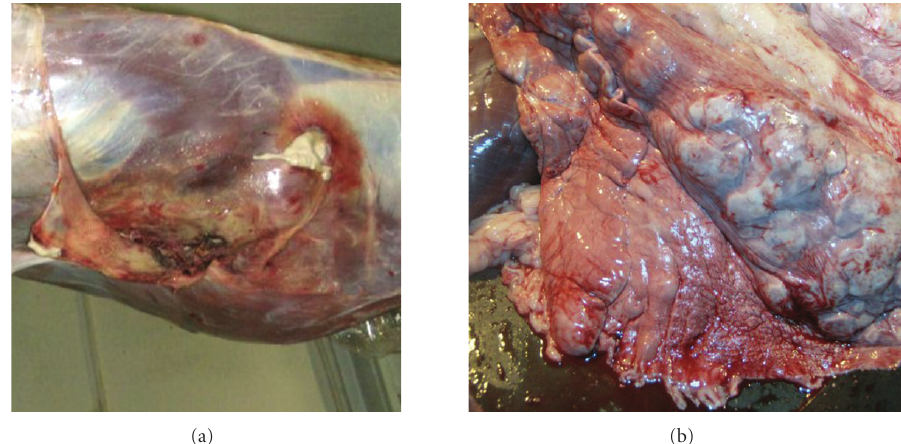
Figure 1: Gross lesions in elk. (b) demonstrates a tuberculous thoracic lesion that has eroded through the body wall. (a) demonstrates coalescing, multinodular, pulmonary granulomas. Orientation of both photographs: cranial to the left and dorsal to the top.